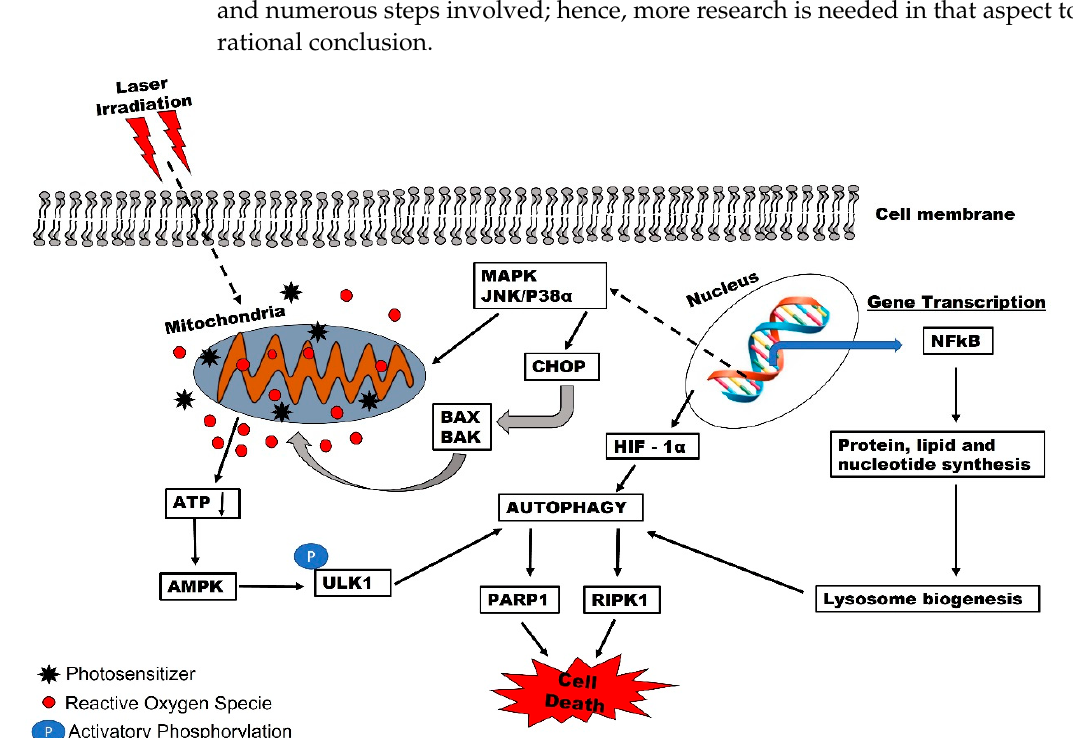
Figure 1. Autophagy-mediated response to photodynamic therapy (PDT). Photosensitizer activation in the mitochondria enhances the formation of ROS and decreases ATP production. Energy sensing AMPK activates the ULK1 to initiate autophagy. PDT can also trigger autophagy machinery NFkB for protein, lipid, and nucleotide synthesis to initiate lysosome biogenesis and autophagy. Mitochondria photo-oxidation can transcriptionally regulate autophagy through MAPK, CHOP , and HIF—1 α .